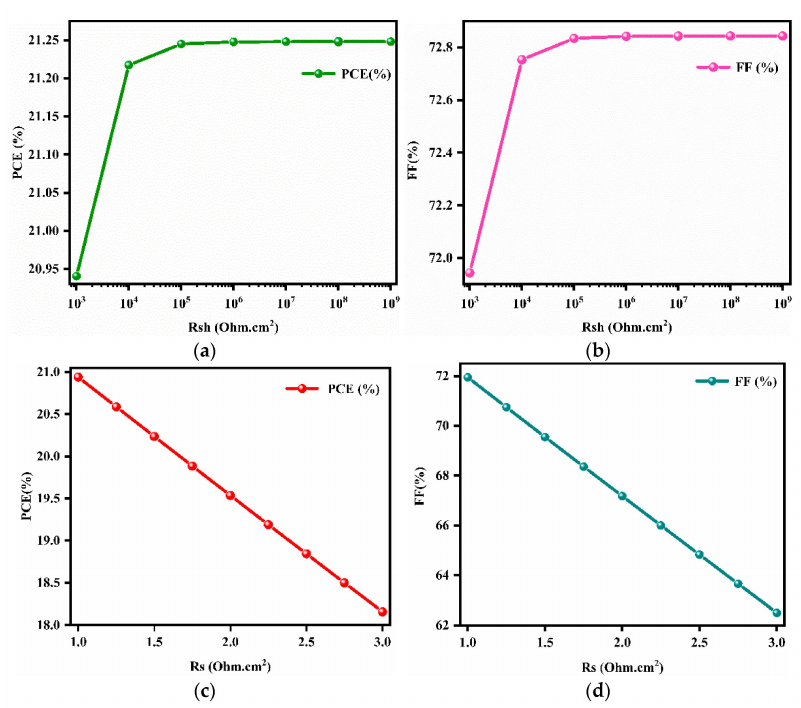
Figure 6. ( a – d ): Impact of resistance variation on ( a ) power conversion efficiency (PCE) for shunt resistance and ( b ) fill factor (FF) for shunt resistance; ( c ) PCE for series resistance and ( d ) FF for series